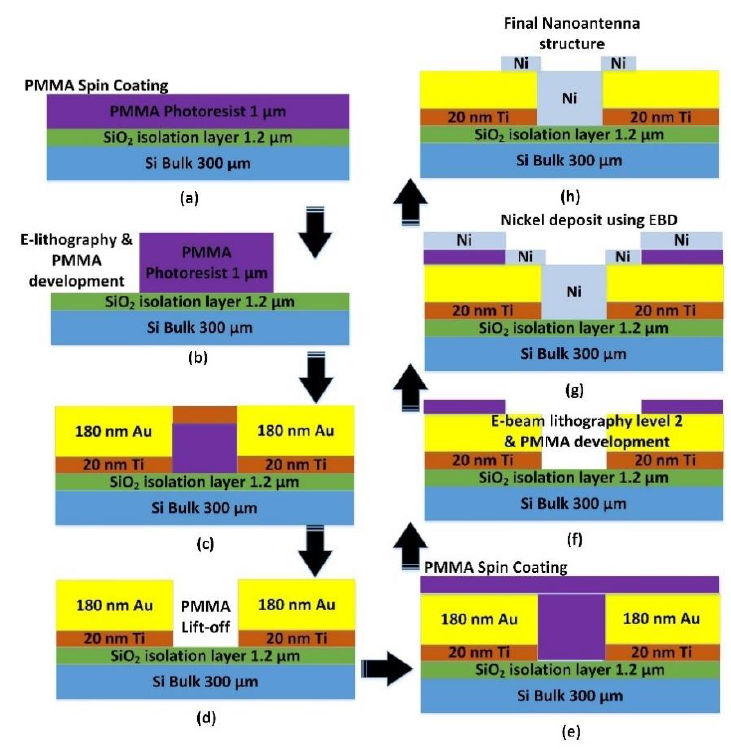
Figure 4. Process flow cross-section of nanoantenna fabrication. ( a ) PMMA (polymethylmethacrylate) was spin-coated on a silicon wafer; ( b ) e-beam lithography and PMMA development; ( c ) Ti/Au deposition (20 nm and 180 nm); ( d ) PMMA lift-off with acetone; ( e ) PMMA was again spin-coated to cover the design; ( f ) 2nd e-beam lithography and PMMA development; ( g ) Ni was deposited in the cavity; ( h ) PMMA lift-off with acetone.